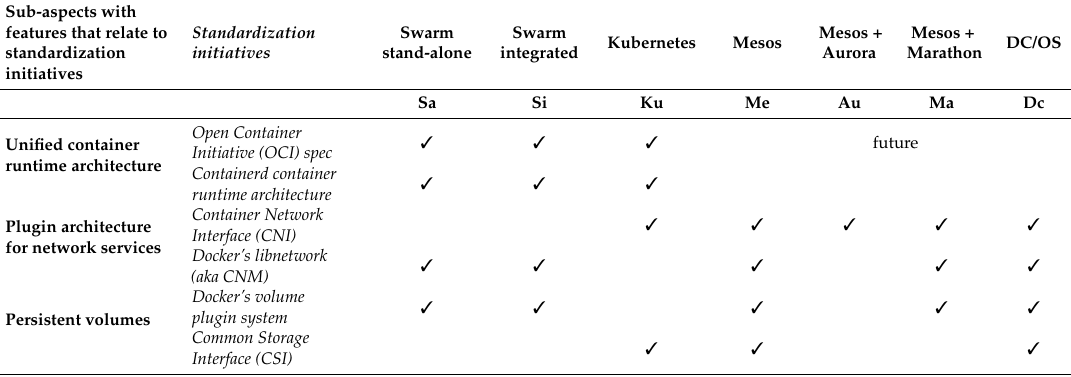
Table 7. Overview of existing standardization initiatives and their